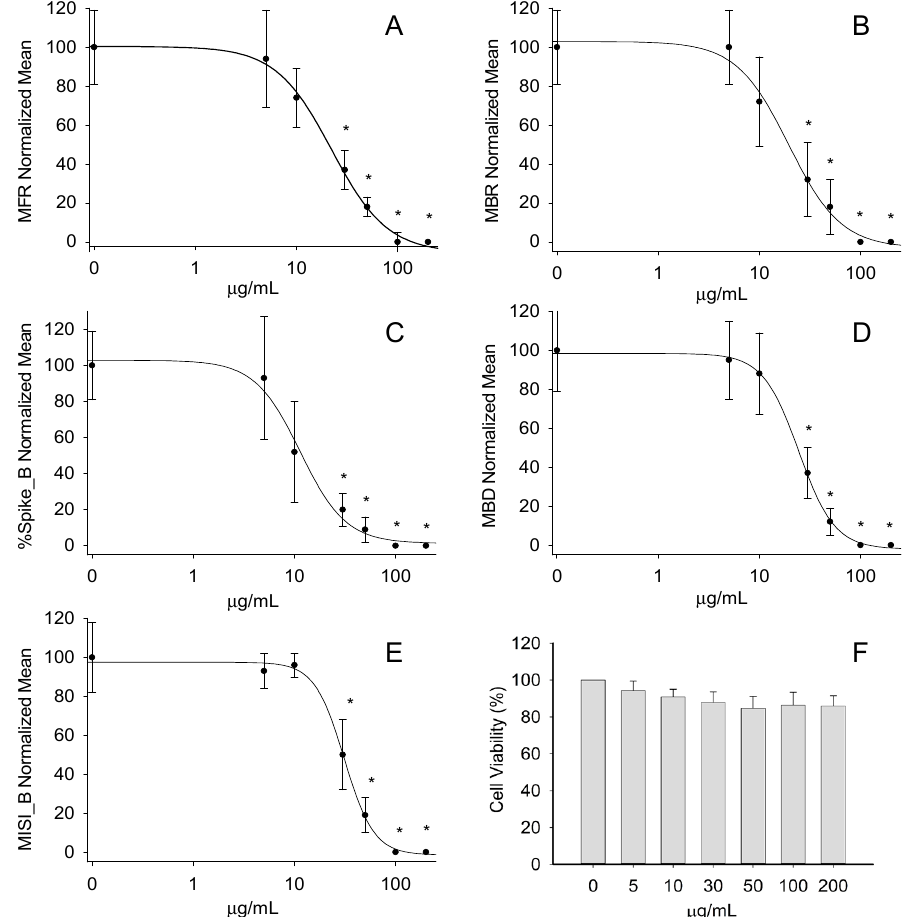
Figure 4. Effect of increasing EO concentrations (5–200 µ g/mL) on the neural network functional activity and viability. The EO showed a concentration-dependent inhibition of all the selected parameters describing the neural network electrical activity: ( A ) mean firing rate (MFR), ( B ) mean burst rate (MBR), ( C ) percentage of spikes in a burst (% Spikes_B), ( D ) mean burst duration (MBD; s), ( E ) mean inter-spike interval within a burst (MISI_B; s) ( n = 6; * p < 0.05). At the bottom right ( F ), the bar graph shows that the EO did not induce any significant effect on the neuronal viability evaluated by means of the MTT assay ( n = 12).